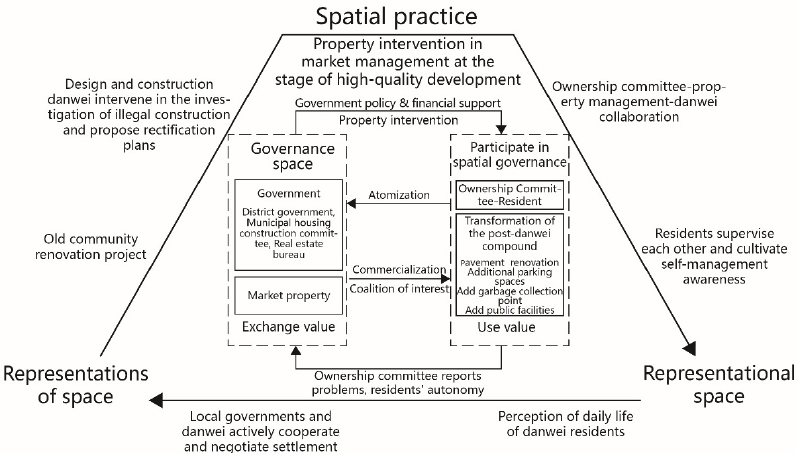
Figure 4. Integrated differential space production path (source: self-drawn by one of the authors).